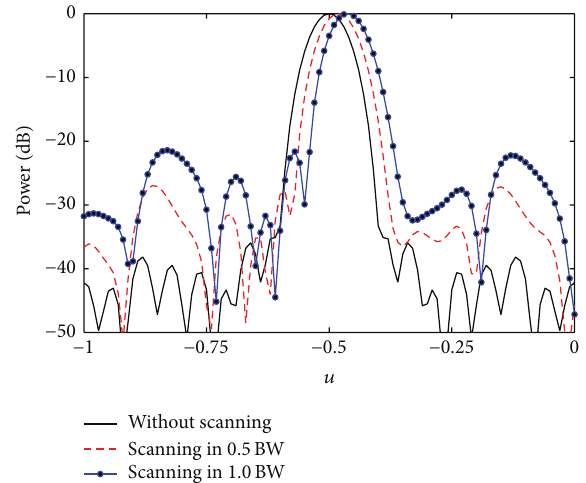
Figure 15: Array patterns with beam scanning obtained by GSP (azimuth